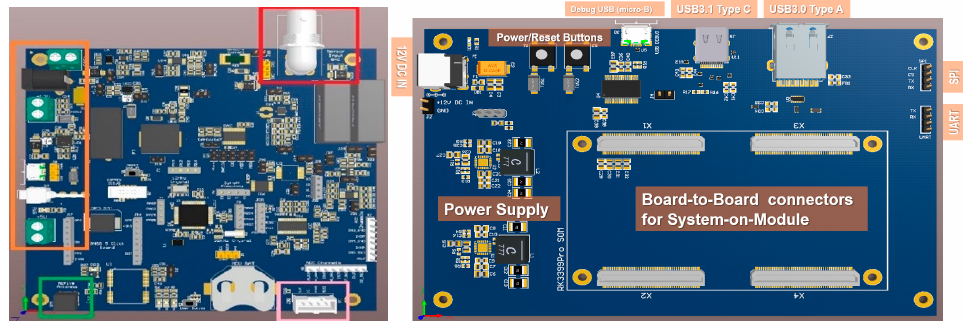
Figure 3. Sensor Data Receiving ( left ) and Data Processing ( right ) Interfaces.